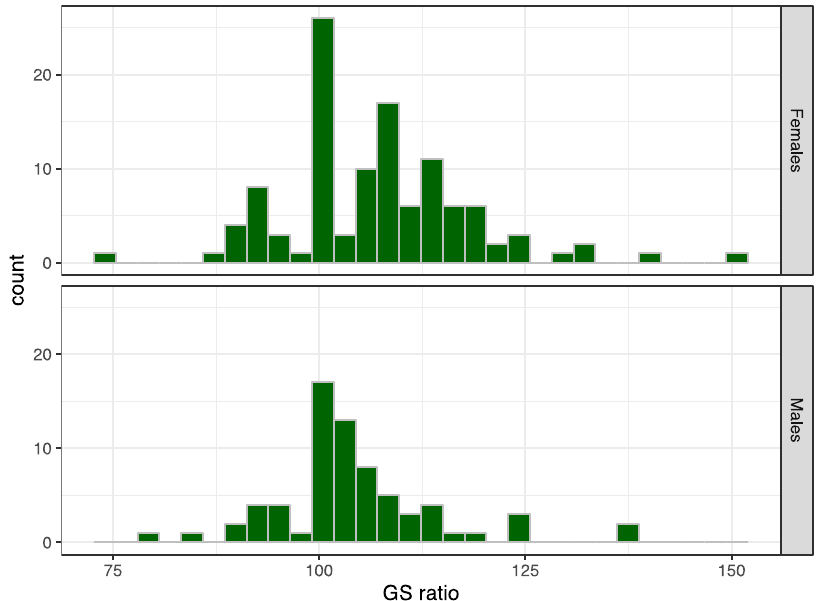
Figure 4. GS ratio for male and female weightlifters.